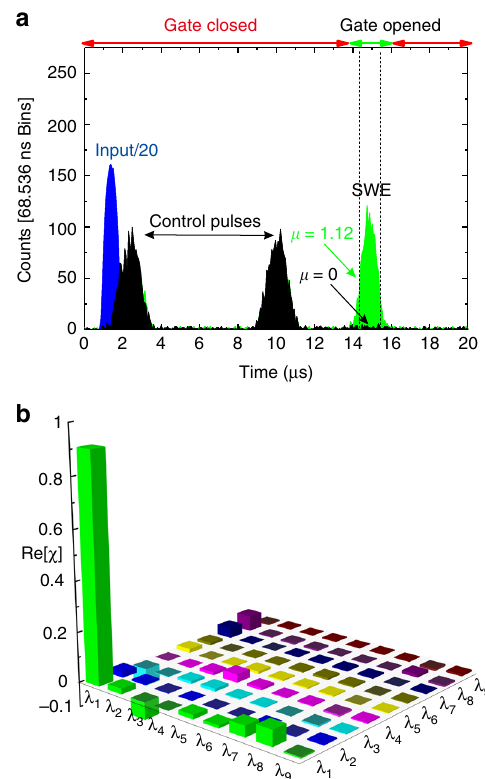
Fig. 2 Time histograms and the reconstructed process matrix of quantum storage process in three-dimensional OAM space. a Time histograms of the input photons (blue), the photons retrieved at 12.68 μ s for μ = 1.12 (green) and the unconditional noise for μ = 0 (black). b Graphical representation of the process matrix χ of memory process as estimated via quantum process tomography. Details of operators λ i are shown in Section Methods. Only the real part of the experimentally reconstructed process matrix is shown. All values are in the imaginary part are smaller than